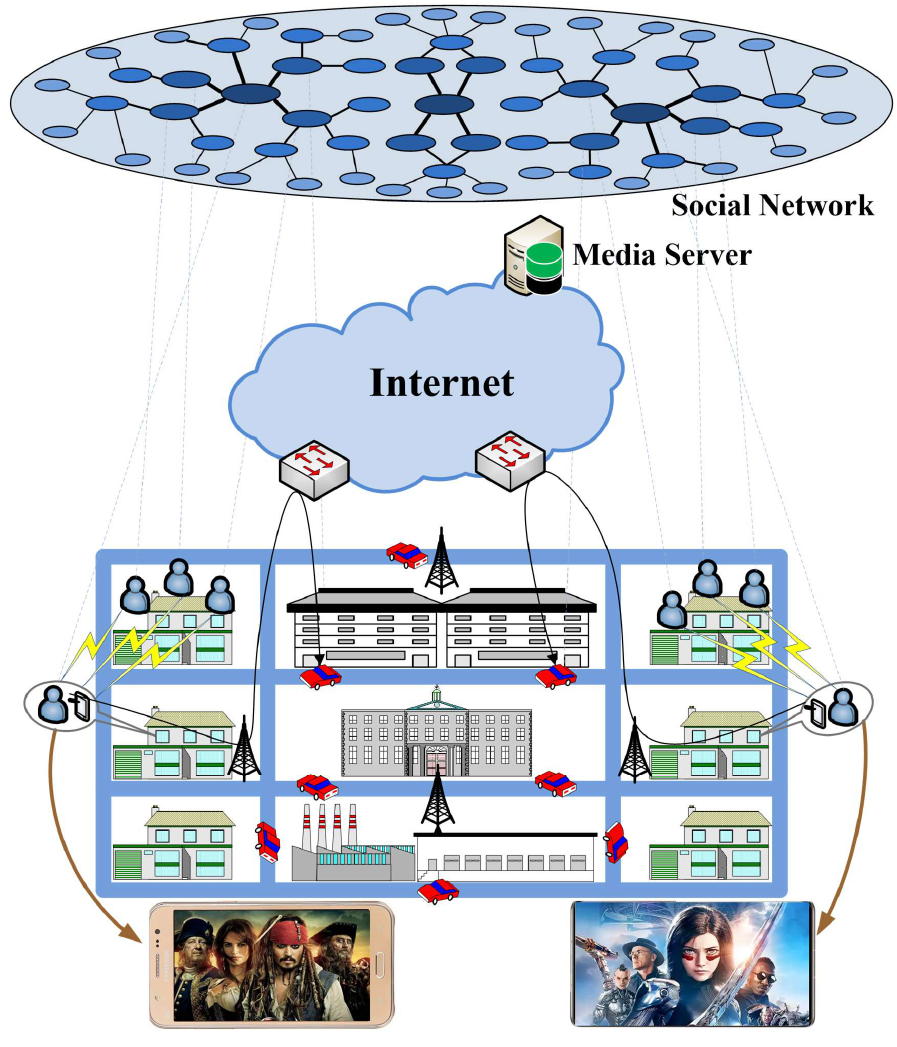
Figure 1. Social-based video sharing in wireless mobile